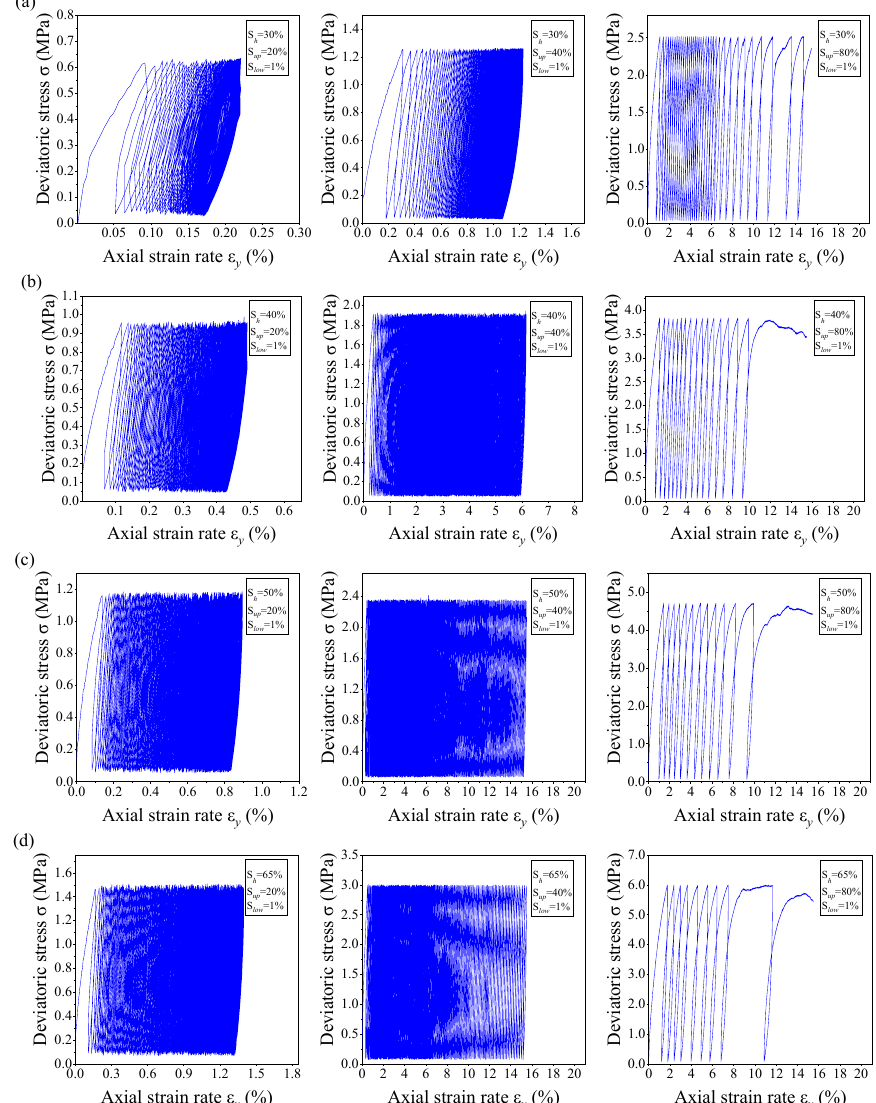
Figure 9. Dynamic stress–strain curves for MHS under different dynamic stress amplitudes and various S h conditions. (a) S h = 30%; (b) S h = 40%; (c) S h = 50%; (d) S h = 65%.